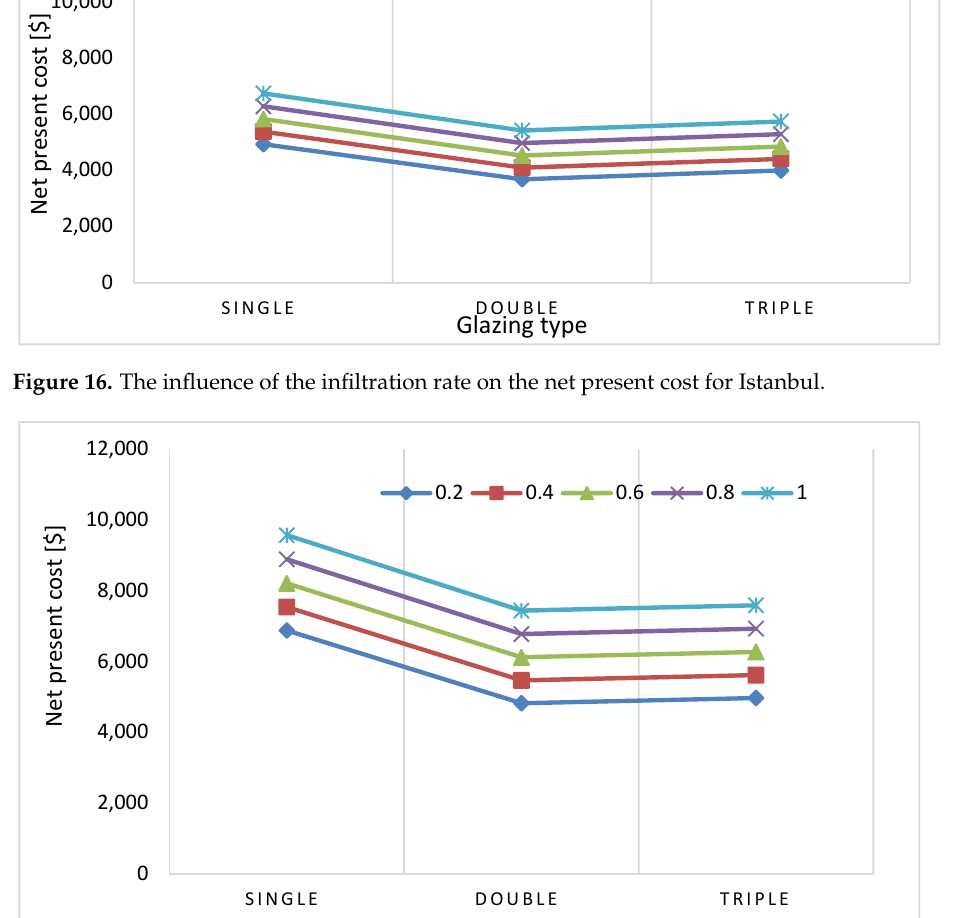
Figure 17. The influence of the infiltration rate on the net present cost for Hakkari .